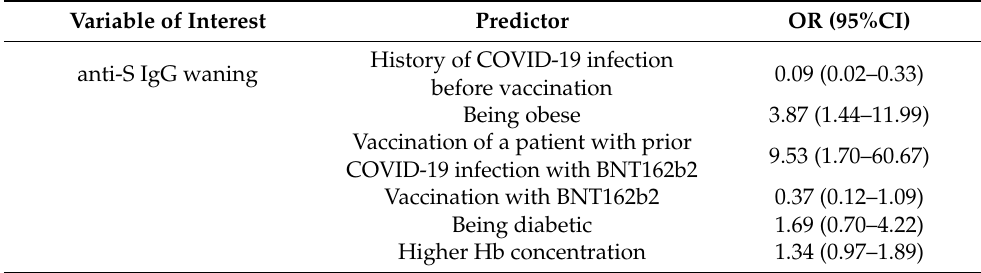
Table 4. Sensitivity analysis. Results of a multivariable logistic regression after removal of patients who contracted COVID-19 during the study duration. Abbreviations: